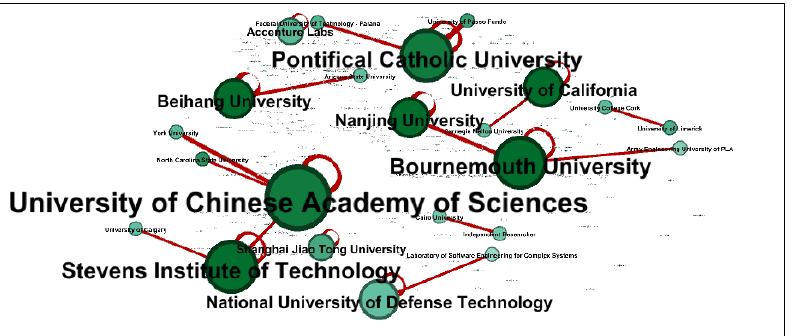
Figure 7. Institutions most frequently involved in co-authorships.